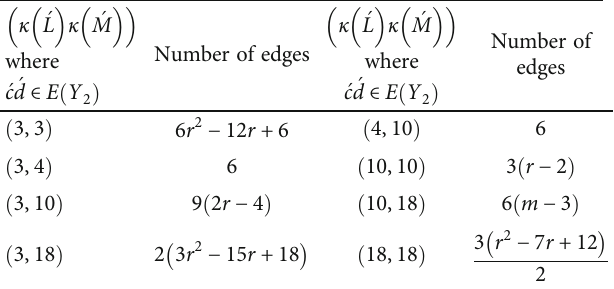
Table 2: Edge partition of a THDN4 ð r Þ based on degrees of end vertices of each edge.